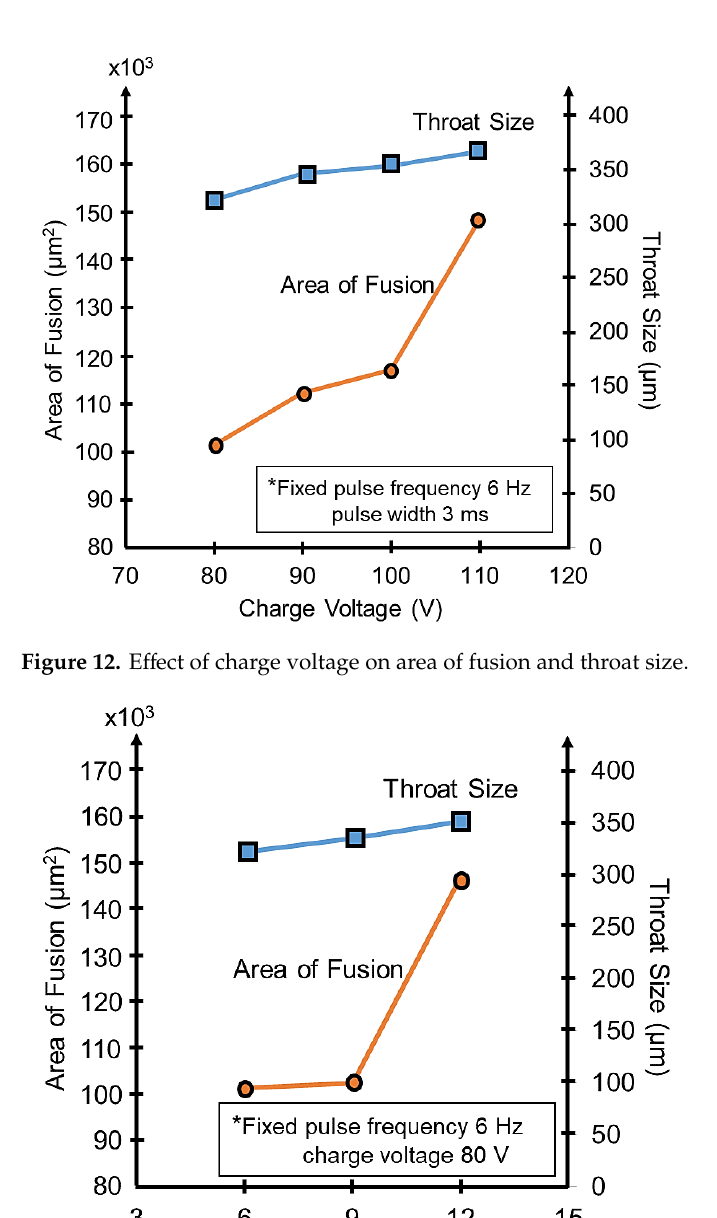
Figure 13. Effect of pulse frequency on area of fusion and throat size.